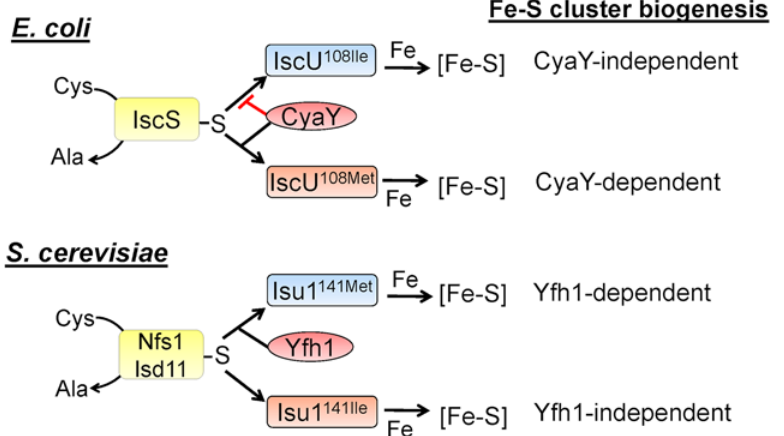
Fig 1. Frataxin involvement in [Fe-S] cluster biogenesis in E . coli and S . cerevisiae . Cysteine desulfurases IscS and Nfd1/Isd11 are shown in yellow, and the frataxin orthologs CyaY and Yfh1 are shown in red. The wild-type scaffold proteins IscU Ile 108 and Isu1 Met 141 are indicated in blue, while the variant proteins are in orange (IscU Met 108 and Isu1 Ile 141 ). In E . coli , CyaY has been shown to inhibit in vitro assembly of Fe-S cluster on wild-type IscU (indicated by red bar), and is required for in vivo [Fe-S] cluster biogenesis in strains containing IscU Met 108 (indicated by black bar). In S . cerevisiae , Yfh1 facilitates [Fe-S] cluster assembly on the wild-type Isu1 (indicated by black bar), while a strain containing Isu1 Ile 141 does not require Yfh1 for in vivo [Fe-S] cluster